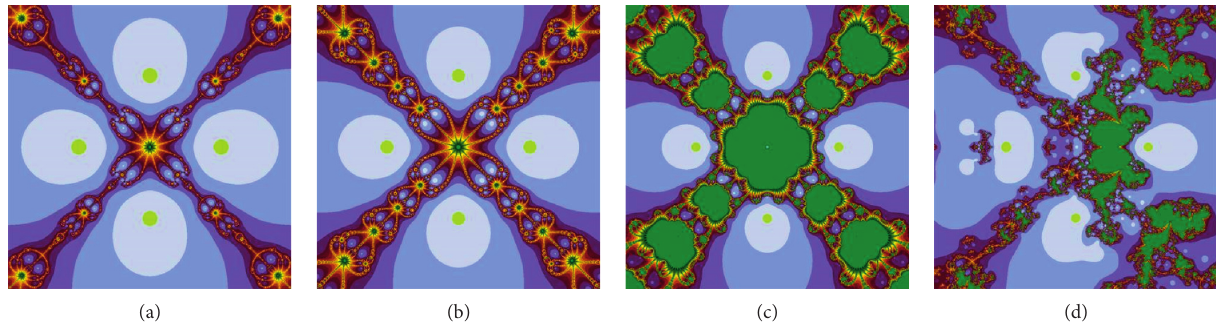
Figure 4: Polynomiographs related to the complex polynomial q (d) Algorithm 1.